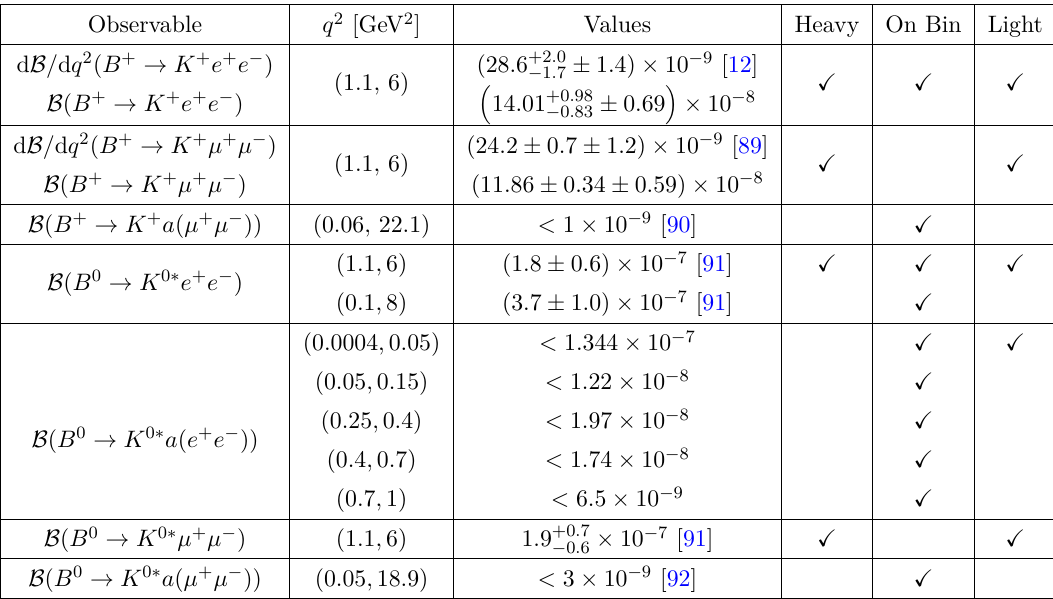
Table 1. The checkmarks correspond to the strongest bounds used in each mass regime analysed in this work. Notice that the second entries in the first two lines have been obtained from the corresponding first entry simply integrating over the bin window spread. For B ( B 0 → K 0 ∗ a ( e + e − )) , no bound can be extracted for q 2 ∈ [0 . 15 , 0 . 25] GeV 2 as the data are incompatible with the SM prediction at more than 2 σ